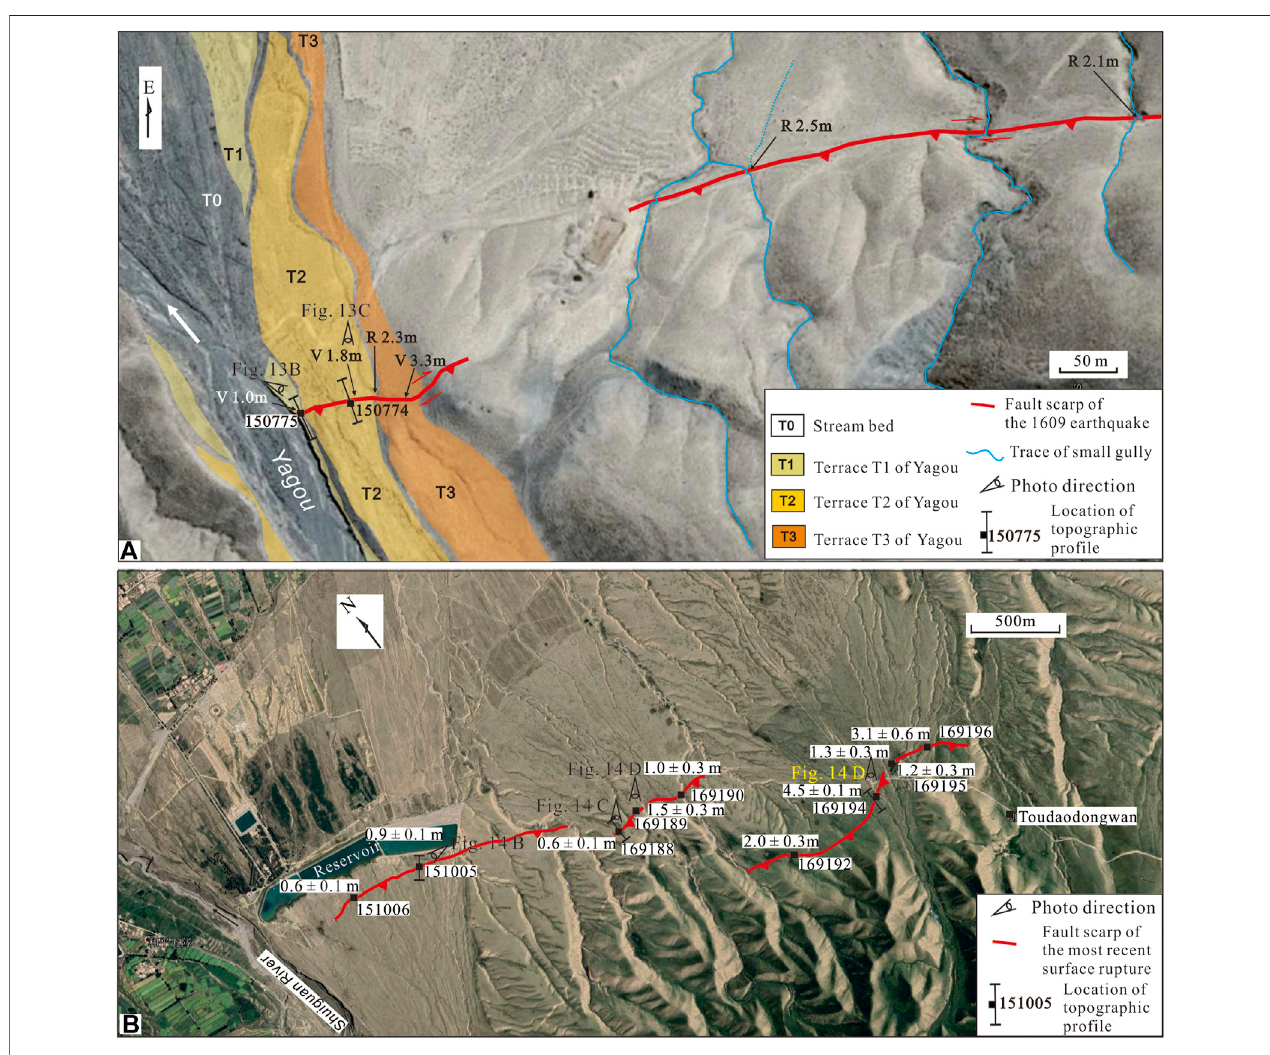
FIGURE 13 | Surface rupture maps of the 1609 earthquake on the Yagou site (A) and Shuiguan River section (B) .